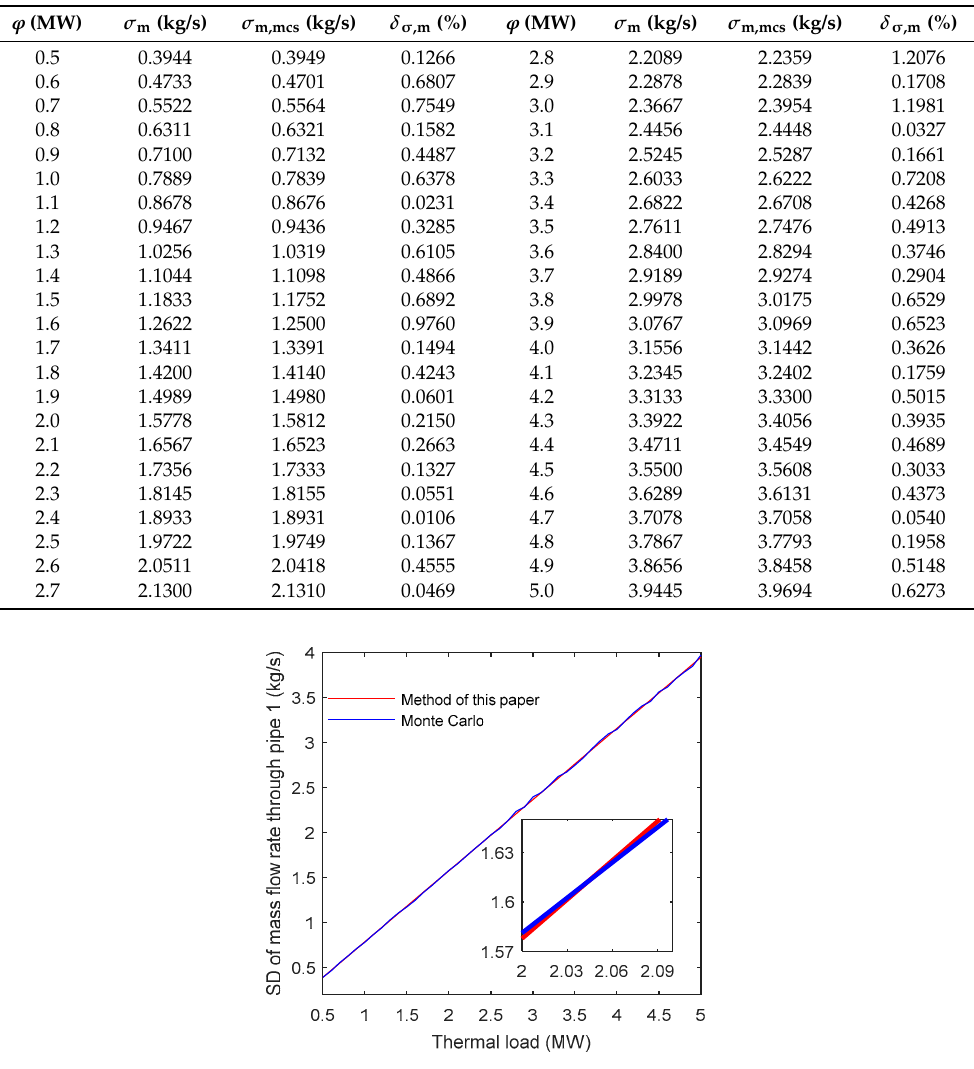
Table 8. Standard deviations of mass flow rate through pipe 1 under different average thermal loads μ ϕ ( σ ϕ = ±10%).